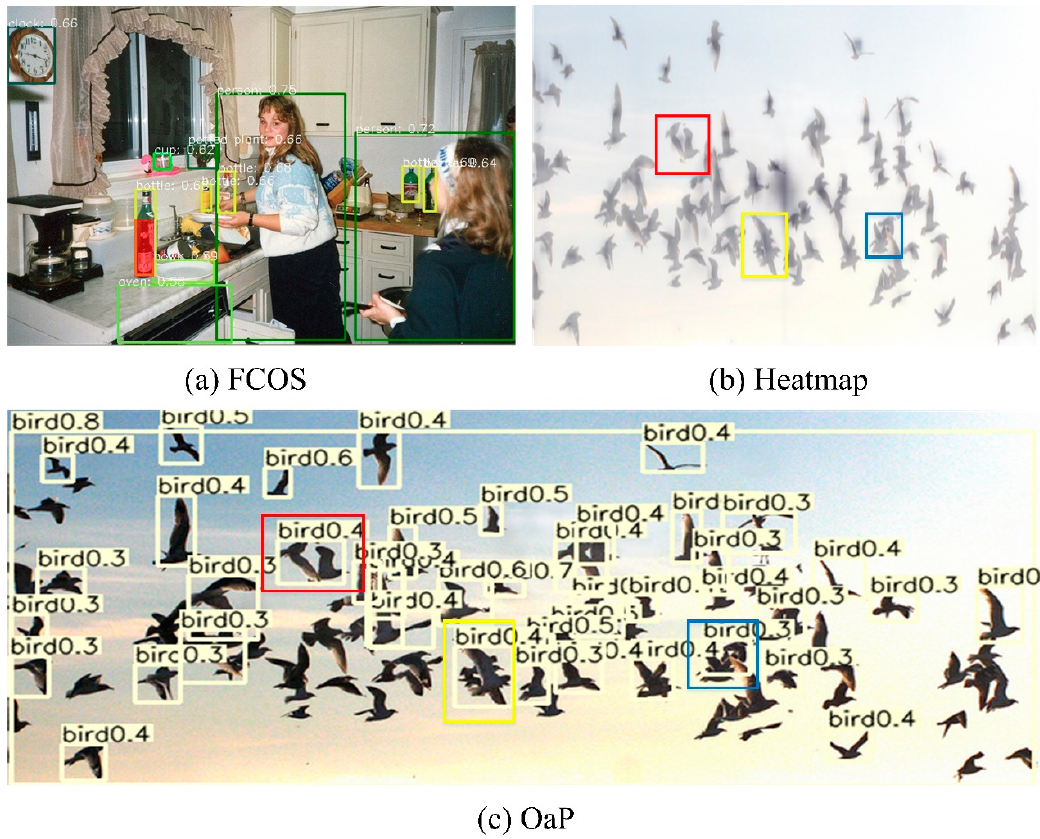
Figure 3. ( a ) Test result of FCOS. ( b ) Heatmap of OaP, ( c ) test result of OaP. In ( b ) ( c ), the red, yellow and blue rectangular boxes correspond to each other. There is a missing target in the rectangular